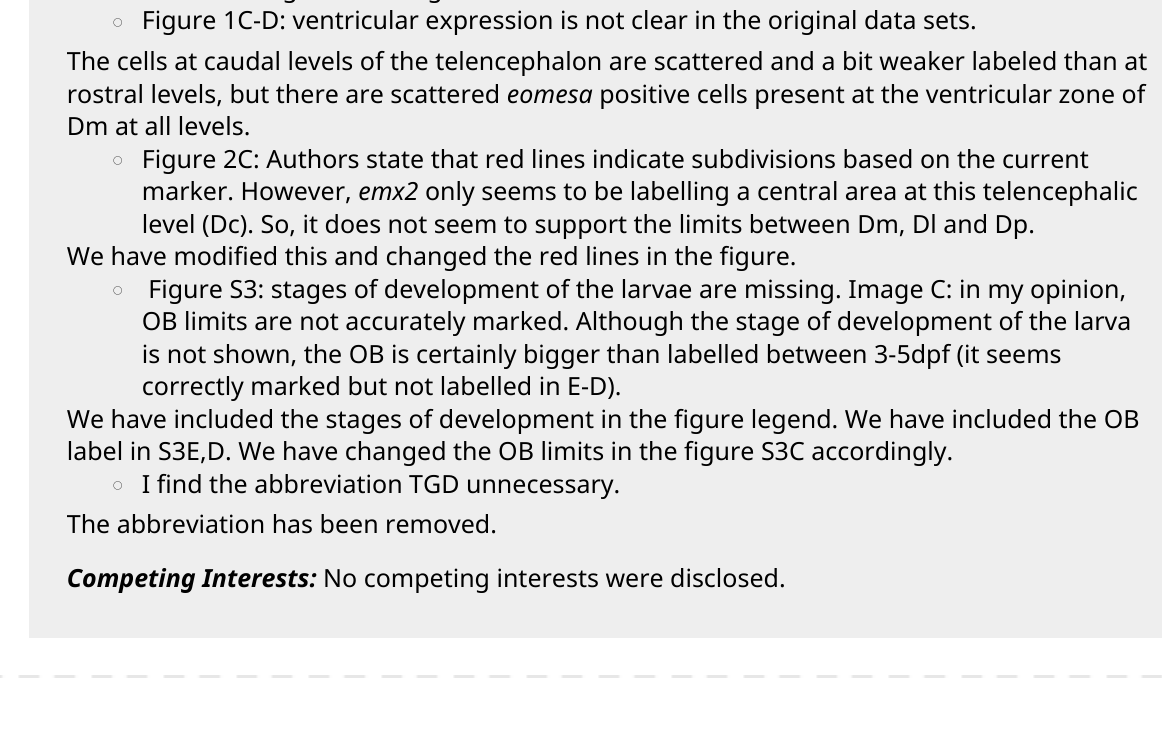
Figure 1C-D: ventricular expression is not clear in the original data sets. ○